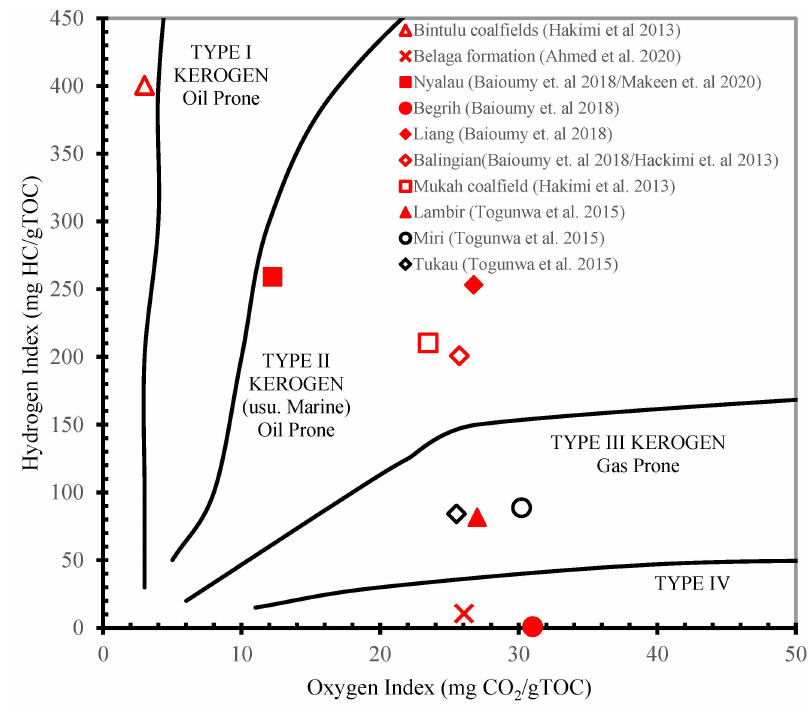
Figure 15. OI versus HI plot showing the type of kerogen of formations in Sarawak.